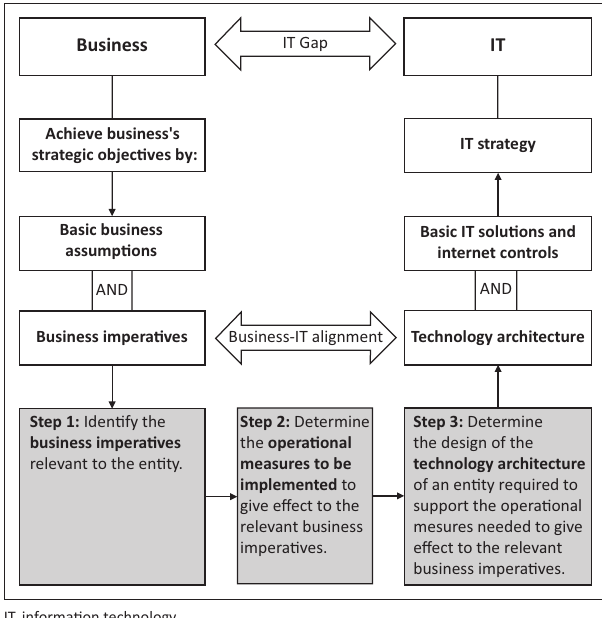
FIGURE 3: Steps to be followed by management in order to successfully achieve business information technology